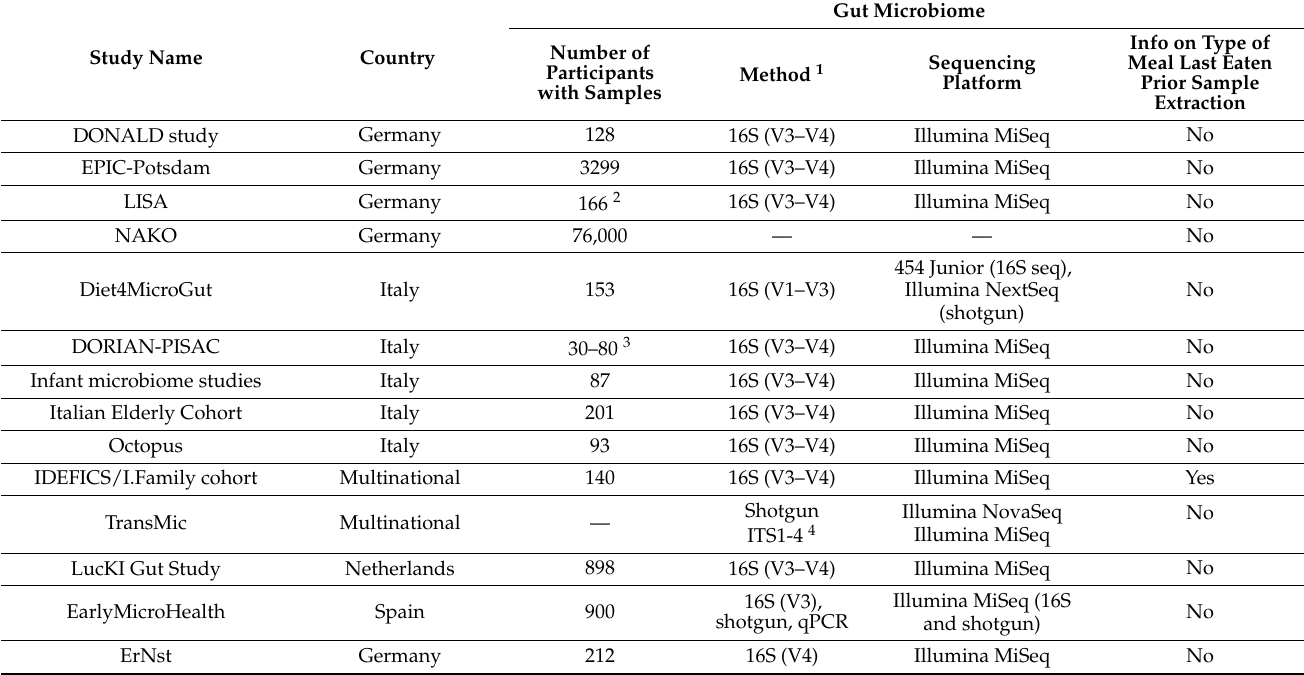
Table 4. Gut microbiome assessment in stool samples from the observational studies participating in the KP-INTIMIC consortium.